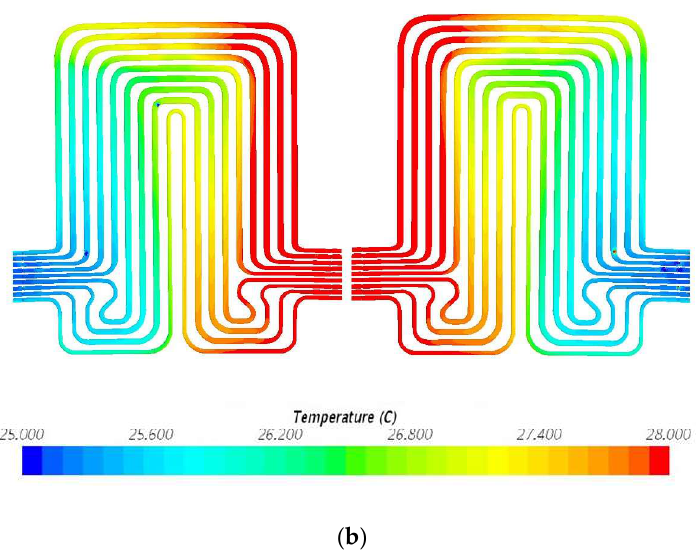
Figure 9. Temperature profile at 60 A and 25 ◦ C with heat flux values near cathode = 1597.3 W / m 2 , anode = 1851.6 W / m 2 , and mid surface = 413.0 W / m 2 . ( a ) Top view and ( b ) bottom view.